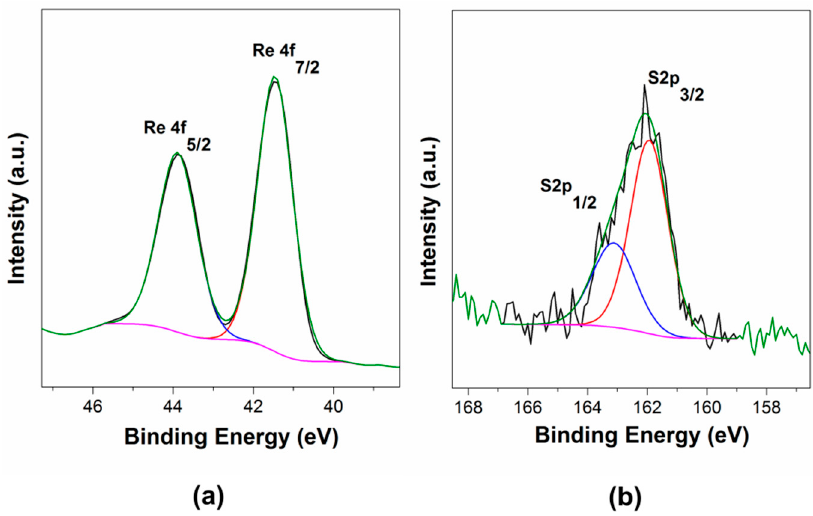
Figure 3. X ‐ ray photoelectron spectroscopy (XPS) spectra of ( a ) Re 4f and ( b ) S2p core levels of the ReS 2 /C composite.